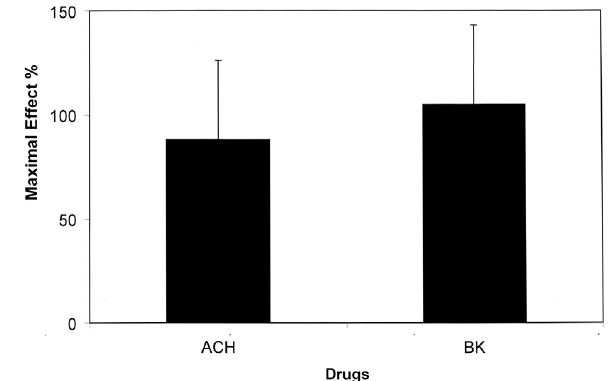
Figure 1 - Percentage maximal response from baseline (maximal effect, %) after infusion of acetylcholine (ACH) and bradykinin